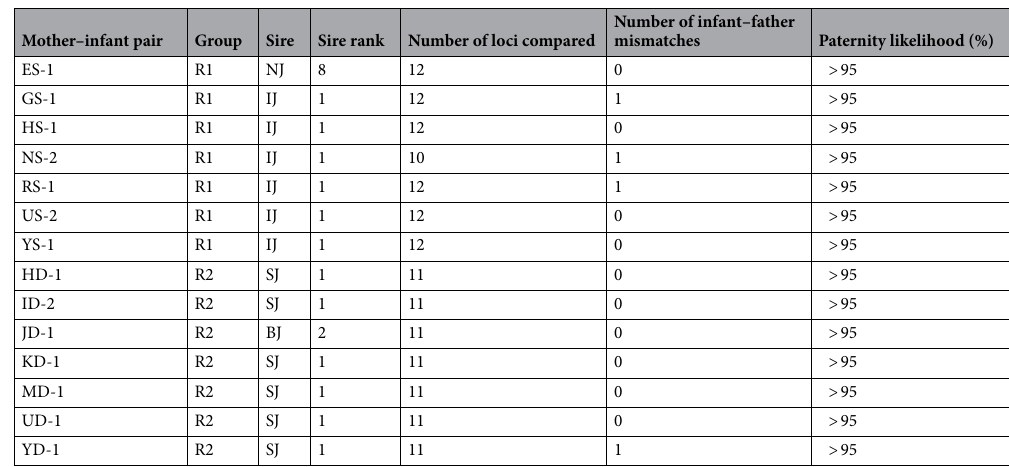
Table 1. Results of the genetic paternity analysis for 14 mother–infant pairs. The table shows the identity of the mother-infant pair, the mother-infant pair’s group, the most likely father, his rank at the time of conception, and the paternity likelihood as calculated with Cervus